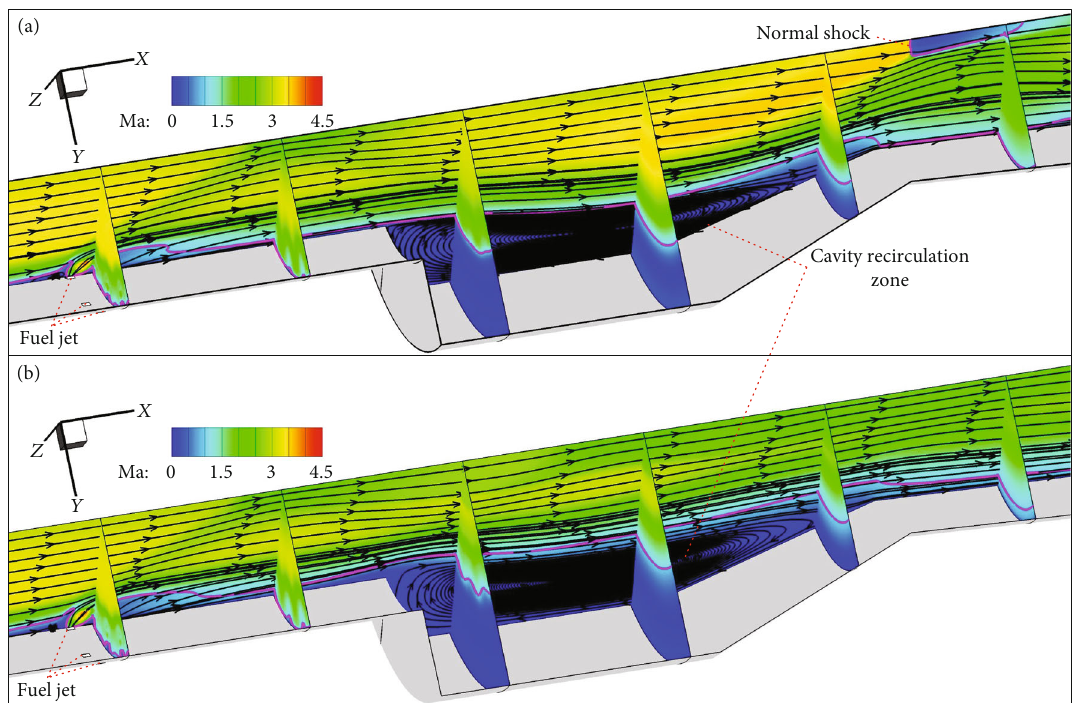
Figure 5: Slices of Mach number contour of (a) the nonreacting and (b) reacting fl ow fi elds of case-22.5; the pink line is the line of sonic speed.